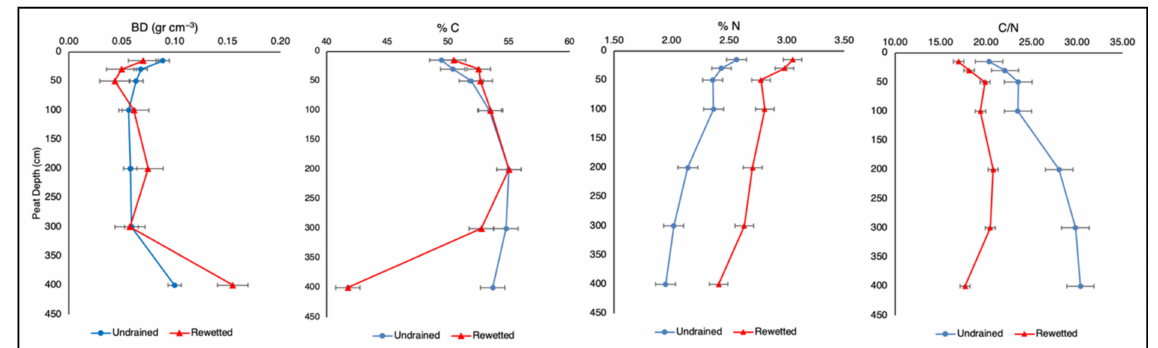
Figure 3. Relationship of bulk density (g cm − 3 ), carbon content (%), nitrogen content (%), and C/N ratio to peat depth at the undrained and rewetted sites. The solid red triangle indicates the rewetted site, and the solid blue circle indicates the undrained site. The error bars represent the standard errors